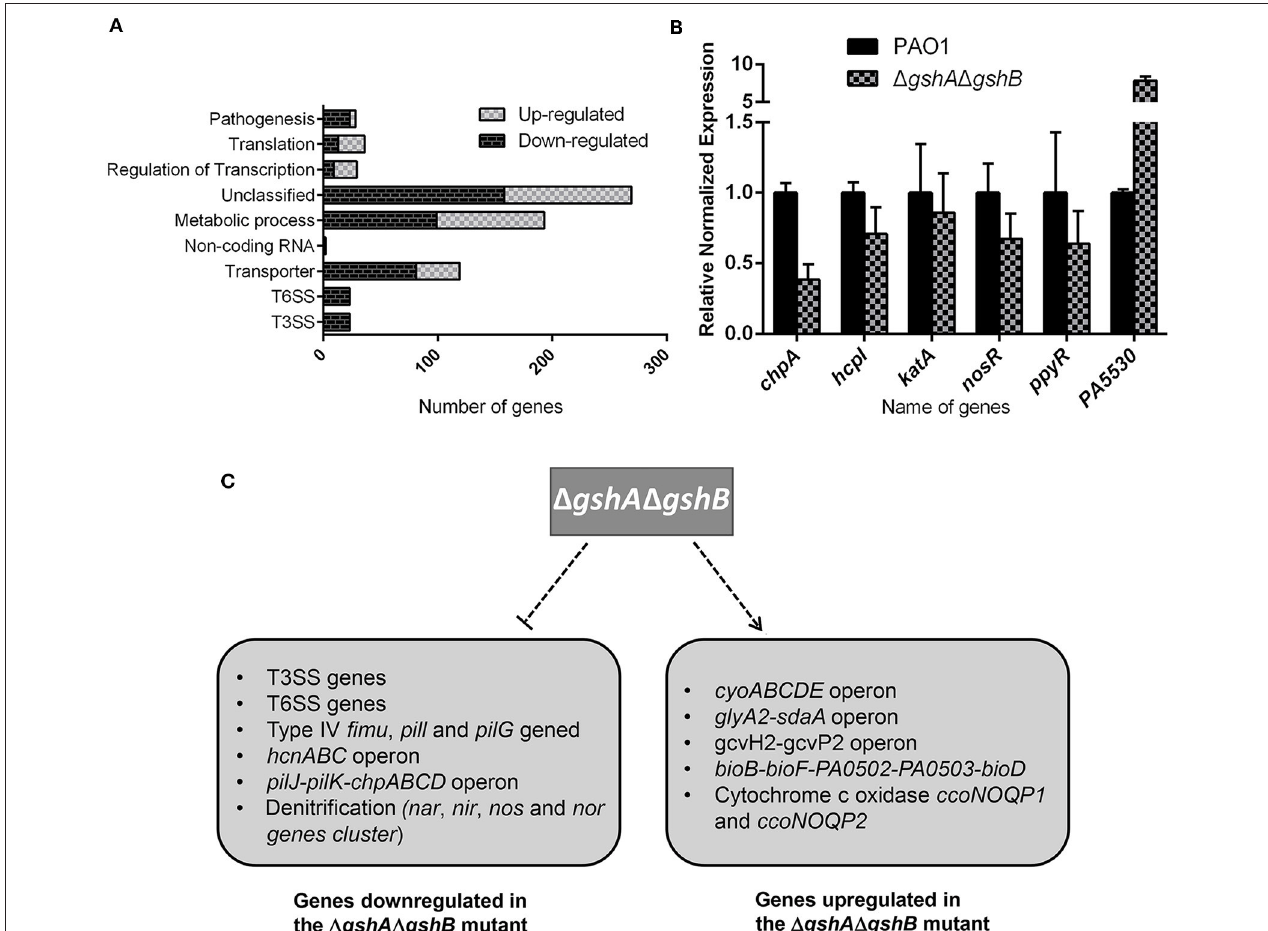
FIGURE 2 | Comparison of the expression of selective genes between wild type PAO1 and 1 gshA 1 gshB . (A) Functional categorization of differentially expressed genes according to their annotated function. Numbers of genes whose expression were altered in 1 gshA 1 gshB compared to PAO1 were shown. (B) RT-PCR analysis of selective genes in PAO1 vs. 1 gshA 1 gshB . All data shown were means ± SEM. RT-PCR assays were performed in triplicate. (C) Summary of major gene categories upregulated or repressed by GSH in P. aeruginosa .